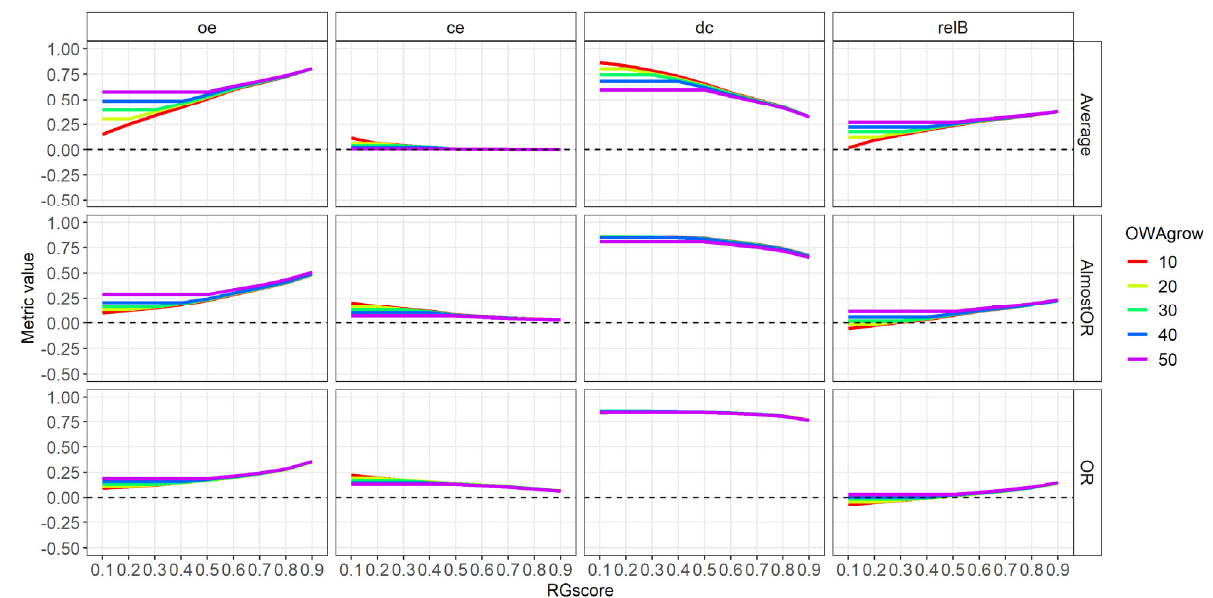
Figure A3. Accuracy metrics (omission error = oe, commission error = ce and Dice coefficient = dc) estimates for burned area maps obtained with the region growing (RG) algorithm over the Vesuvius site. Seed layer is the OWA AND score map and growing layers are: OWA Average , OWA AlmostOR and OWA OR . Accuracy metrics are estimated for combinations of the threshold applied to the growing layers (OWA grow , legend colors) and to the RG score ( x -axis).